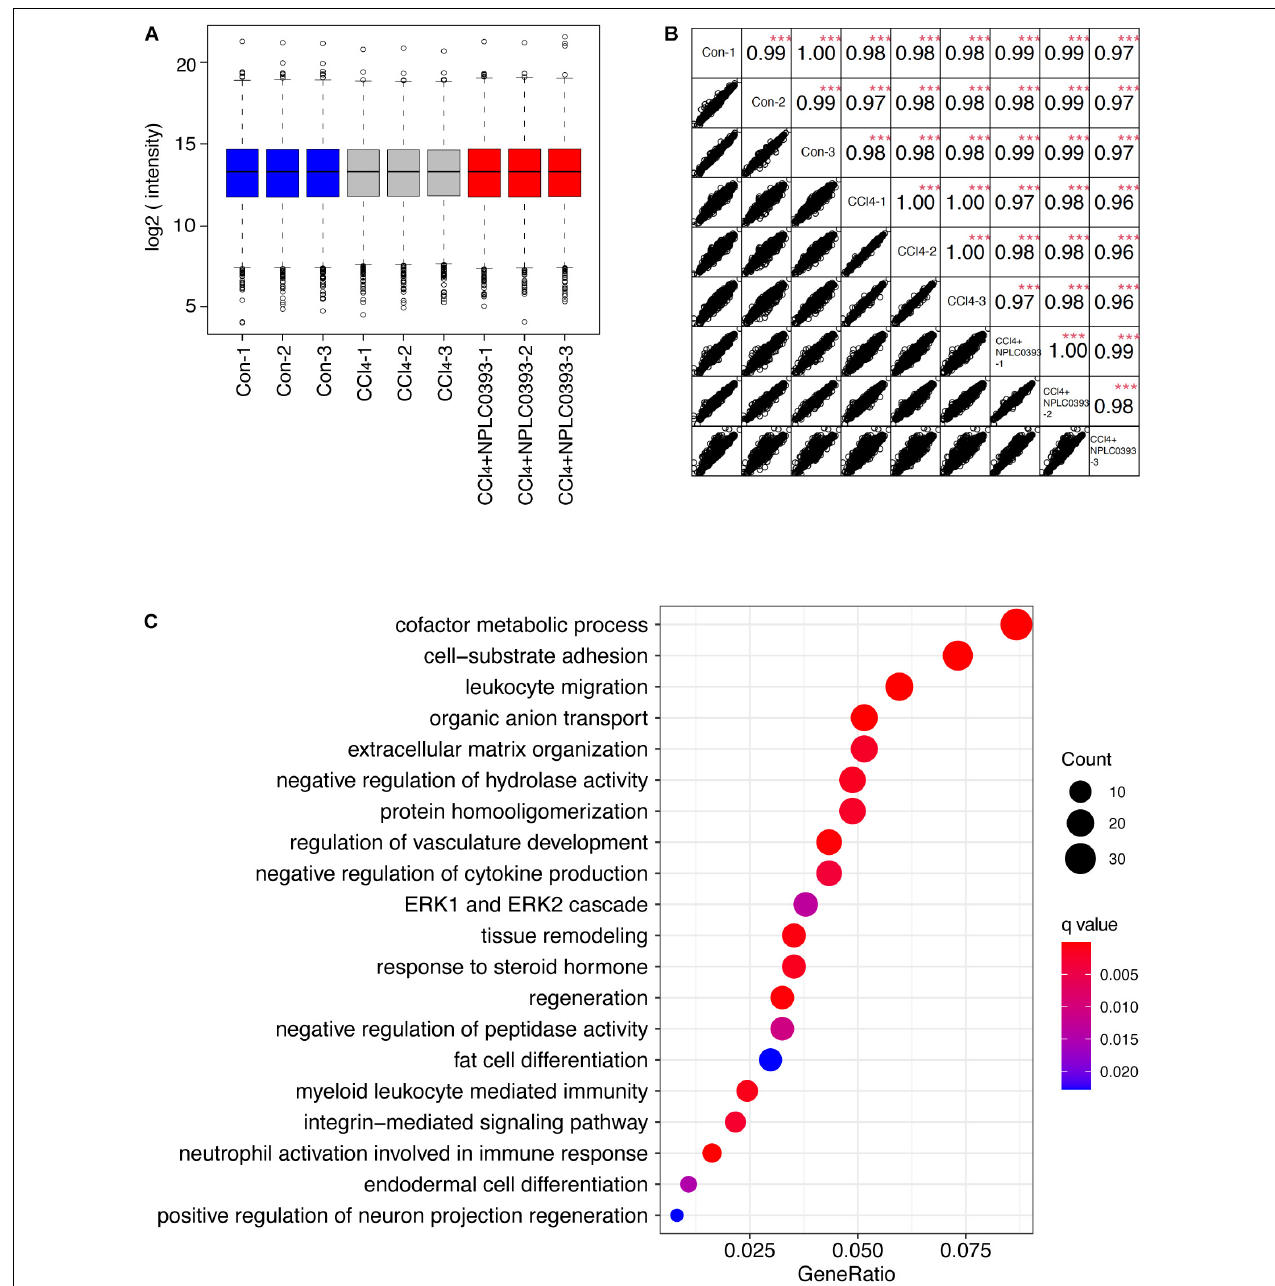
FIGURE 2 | Identification of potential target of NPLC0393 by bioinformatic analysis. (A) Boxplots analysis of protein intensity across all samples. (B) Correlation analysis between each two samples. Rows and columns represent samples, and each square shows the correlation coefficients (Spearman r ) between two samples. *** P < 0.001 comparing intensity of each two samples. (C) GOBP enrichment analysis of the differentially expressed proteins. Values are expressed as GeneRatio and color scale bar indicates adjusted P -value. Node size is proportional to the number of genes associated with the GO